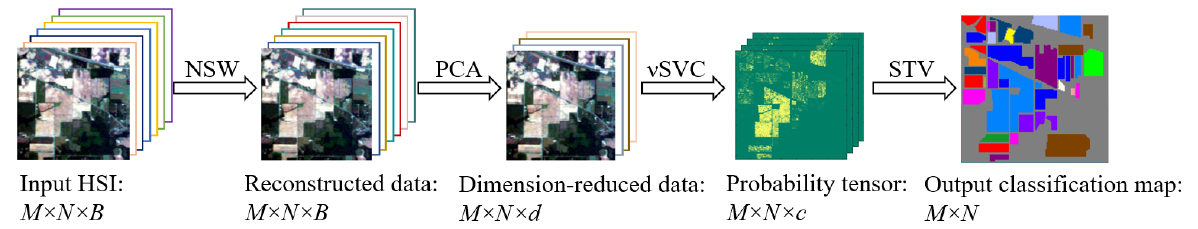
Figure 1. The outline of the proposed method, where d is the reduced dimension and c is the number of classes. Each color represents a class in the output classification